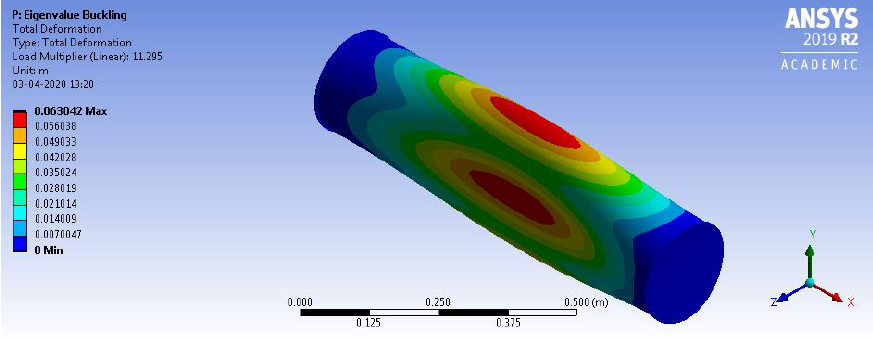
Figure 9. Linear buckling analysis result for the conventional stiffened shell.